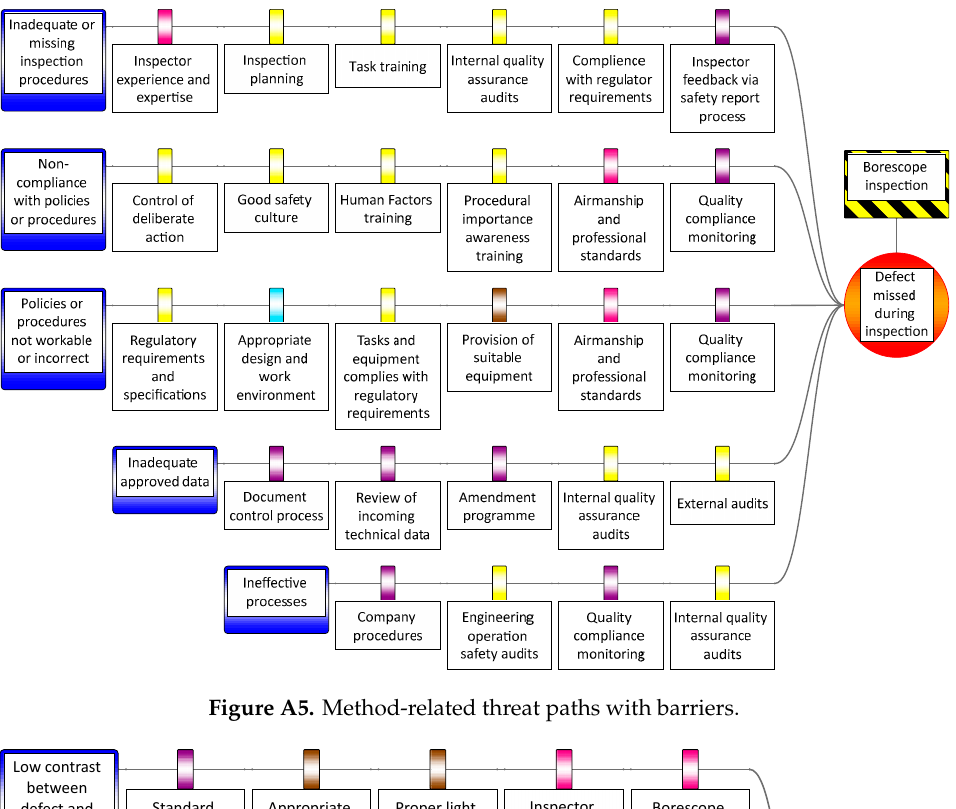
Figure A5. Method-related threat paths with barriers.